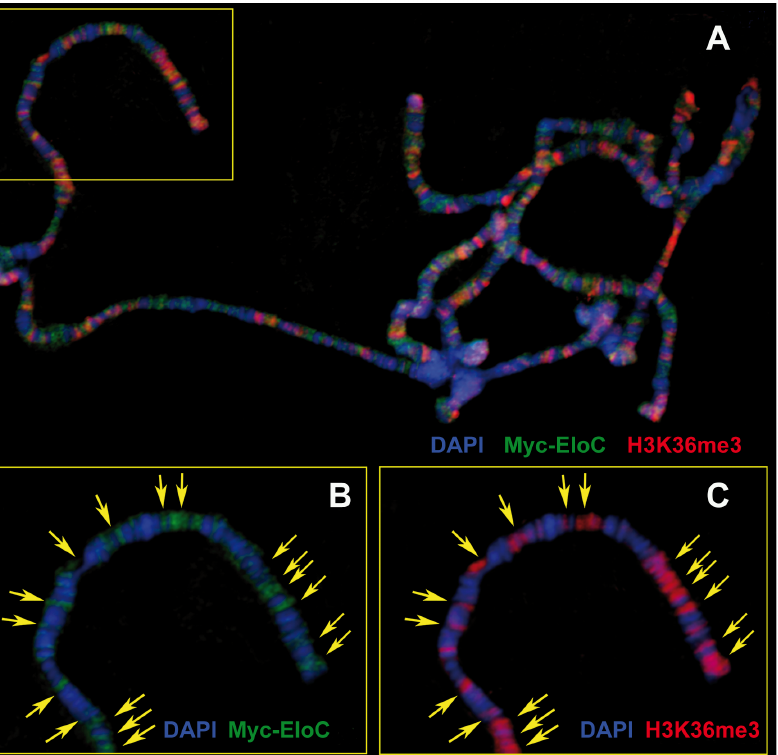
Figure 2. EloC binds polytene chromosomes. (A): Polytene chromosomes from salivary glands of da::Gal4 .. Myc-EloC larva (two sets of chromosomes are shown). Myc-EloC (green) exhibits many co-localizations with H3K36me3 (red). (B, C): Close-up views of the region framed by a yellow rectangle in A. Yellow arrows on B and C indicate co-localizations between Myc-EloC and H3K36me3. DNA was stained with DAPI (blue).